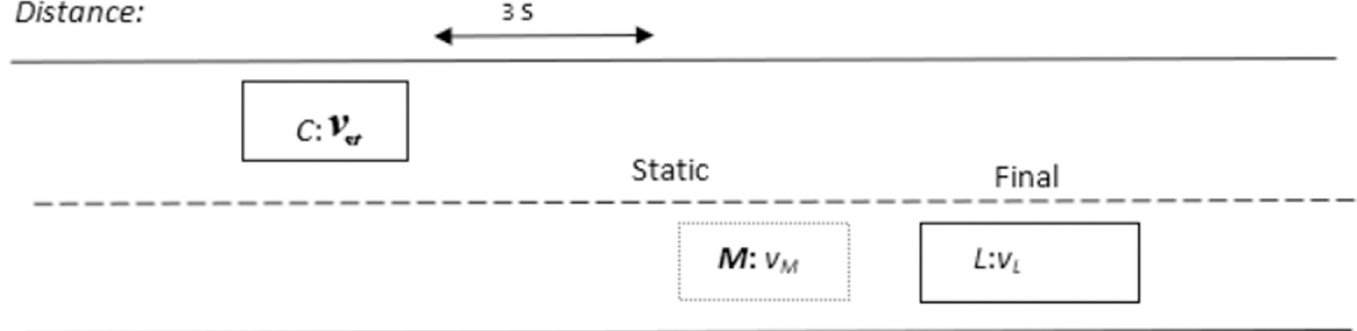
Fig 6. Position of marker targets for scenario 3.